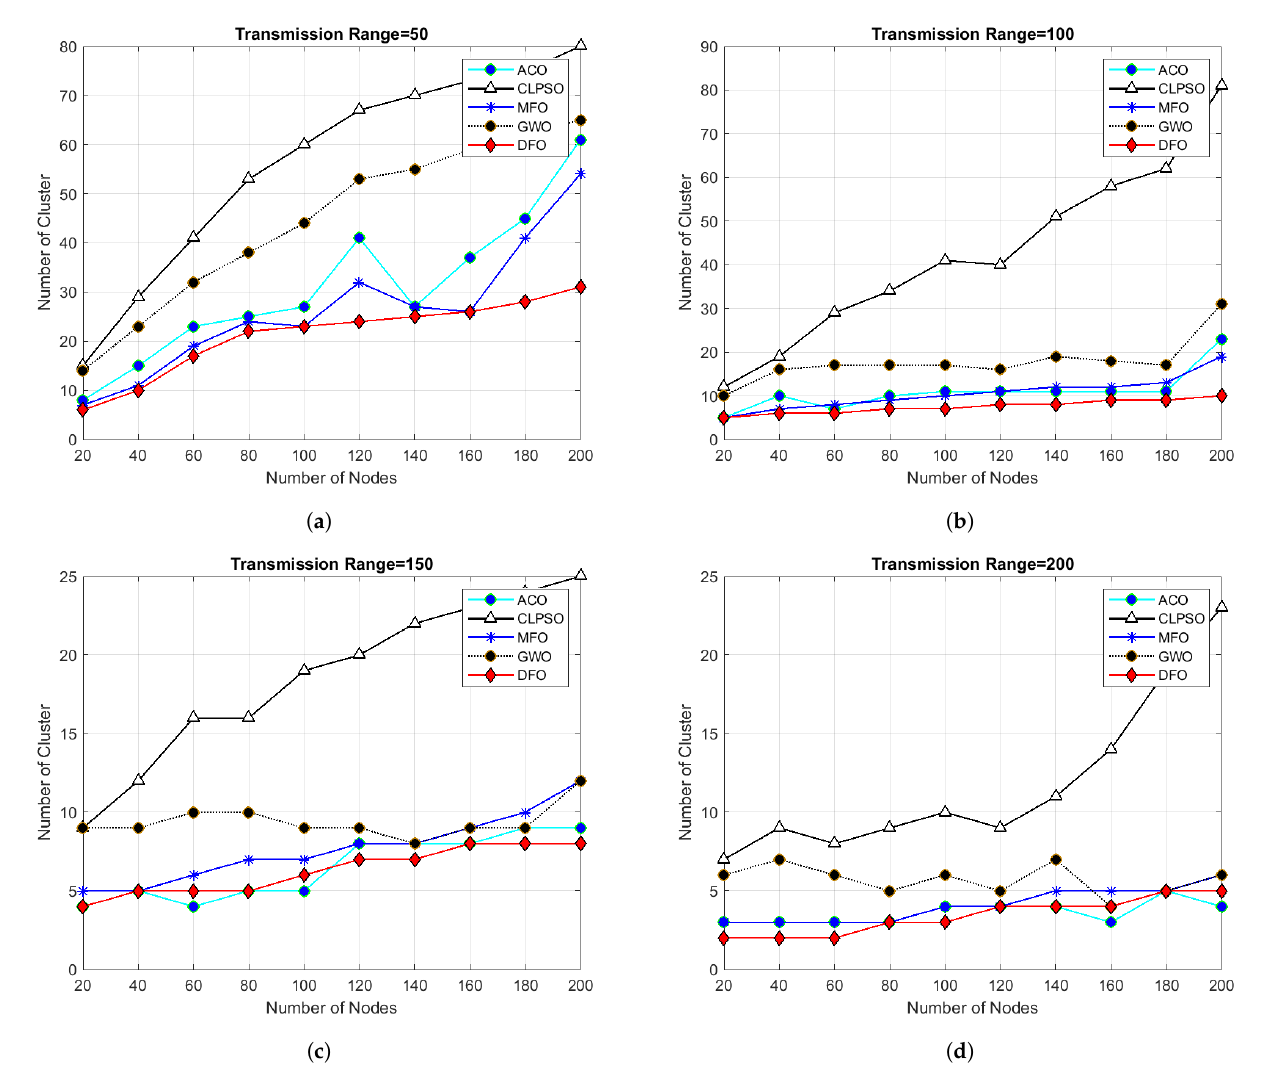
Figure 4. Grid size 500 m × 500 m and number of nodes 20 to